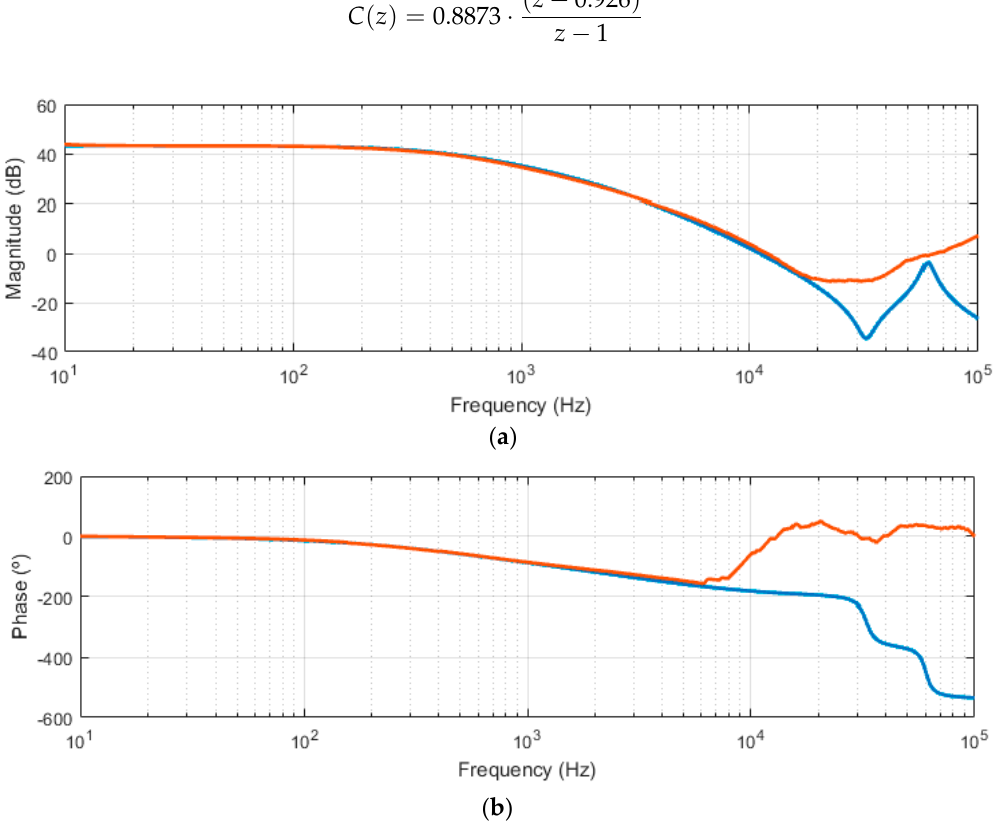
Figure 9. Experimental (orange) and theoretical (blue) Bode plots for the power source operating on scaled output voltage and power using centered-current control. ( a ) Magnitude in (dB) and ( b ) phase in degrees.